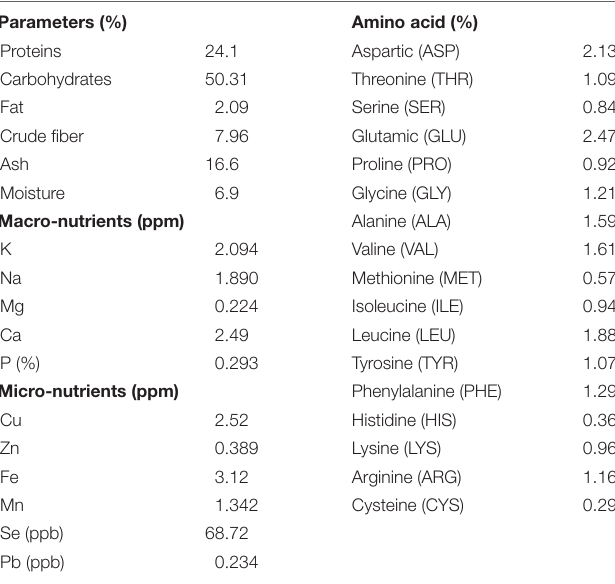
TABLE 1 | Chemical analyses of the dehydrated powder of leaves of the tested sunflower plants ( Helianthus annuus